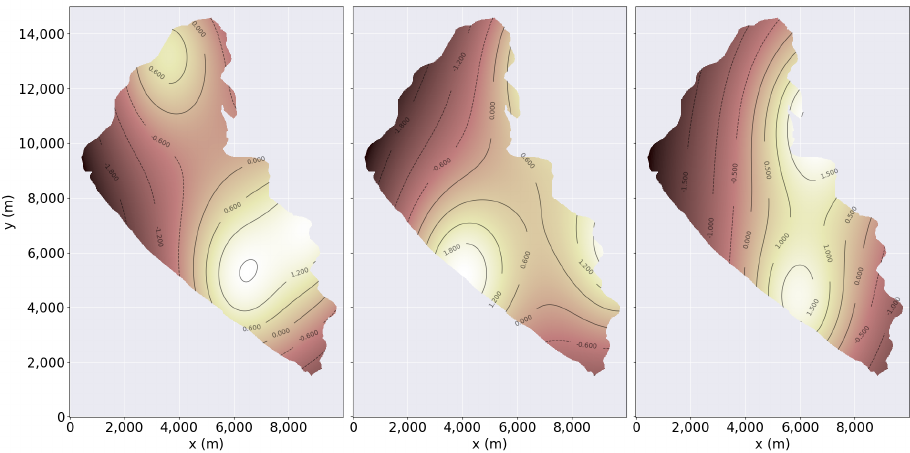
Figure 5. Example of different random simulated ground truth maps using the Shekel function. The maximum locations can overlap and be outside of the feasible set X